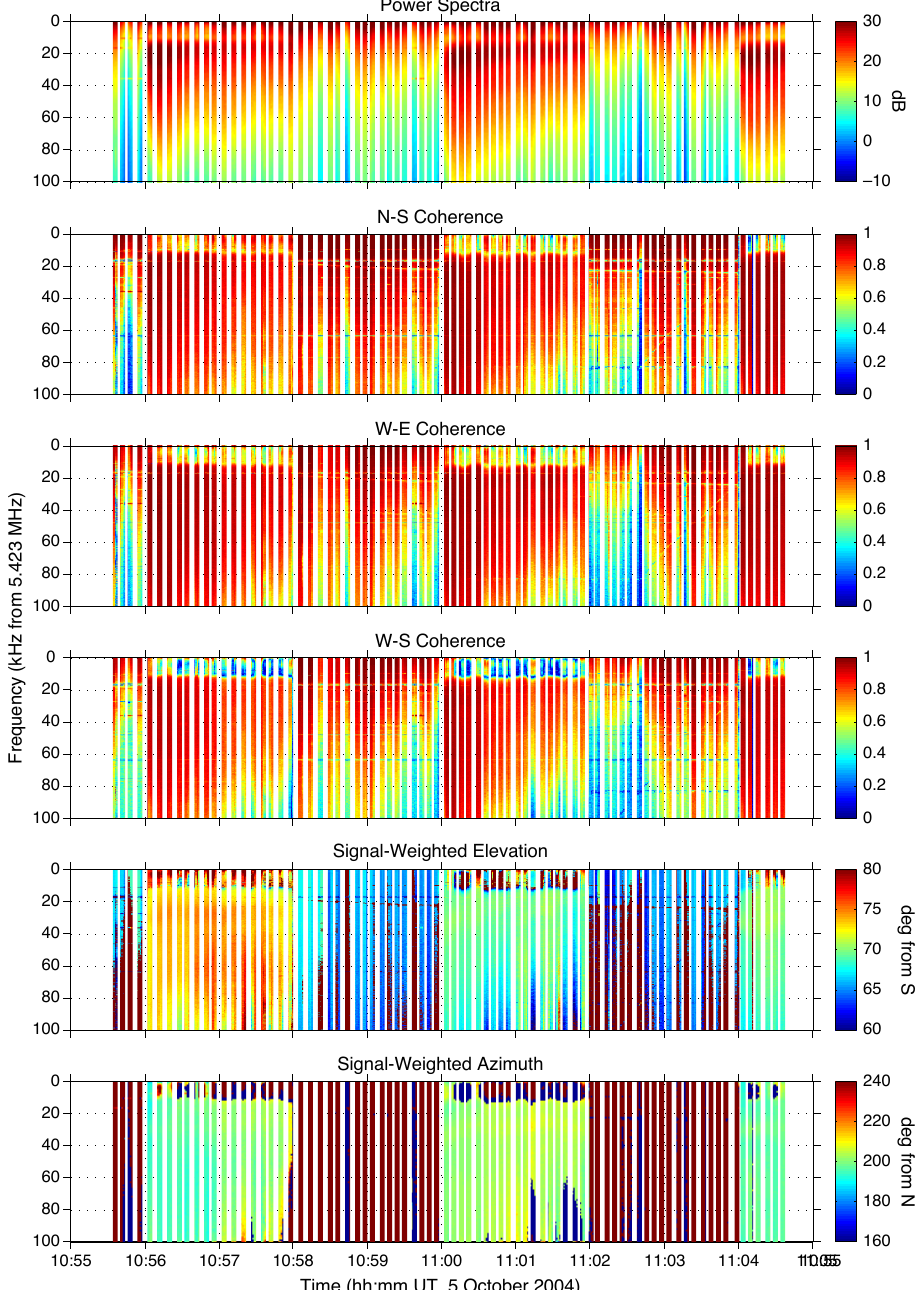
Time (hh:mm UT, 5 October 2004) Isham et al. Figure 13 Fig. 13. SEE interferometer data from 5 October 2004 at EISCAT on Ramfjordmoen. This is the same time period as in Fig. 12 but with an expanded view of the frequency scale encompassing the BUM 1 , and showing the coherences for all three antenna baselines plus elevation and azimuth angles computed for the BUM 1 source region. The elevation angle of the BUM 1 is about 74 ◦ during the pump cycle beginning at 10:56 UT and about 70 ◦ during the follow two cycles. Time and frequency resolutions are 1s and